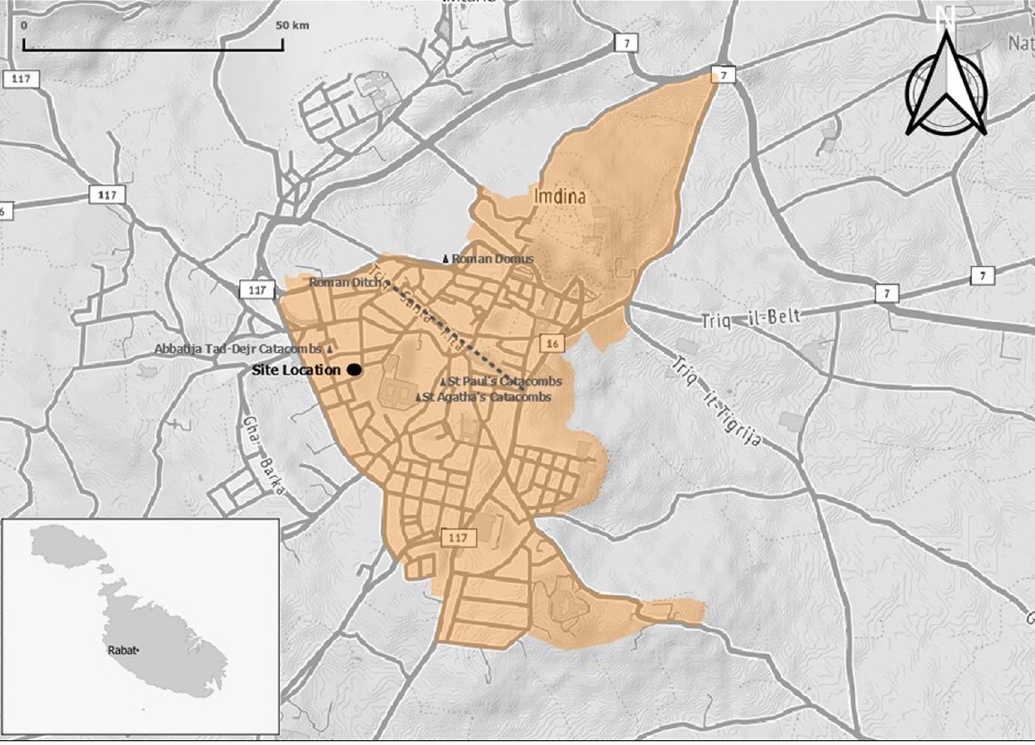
Figure 1: Site at Triq Fej ġ el in the Rabat